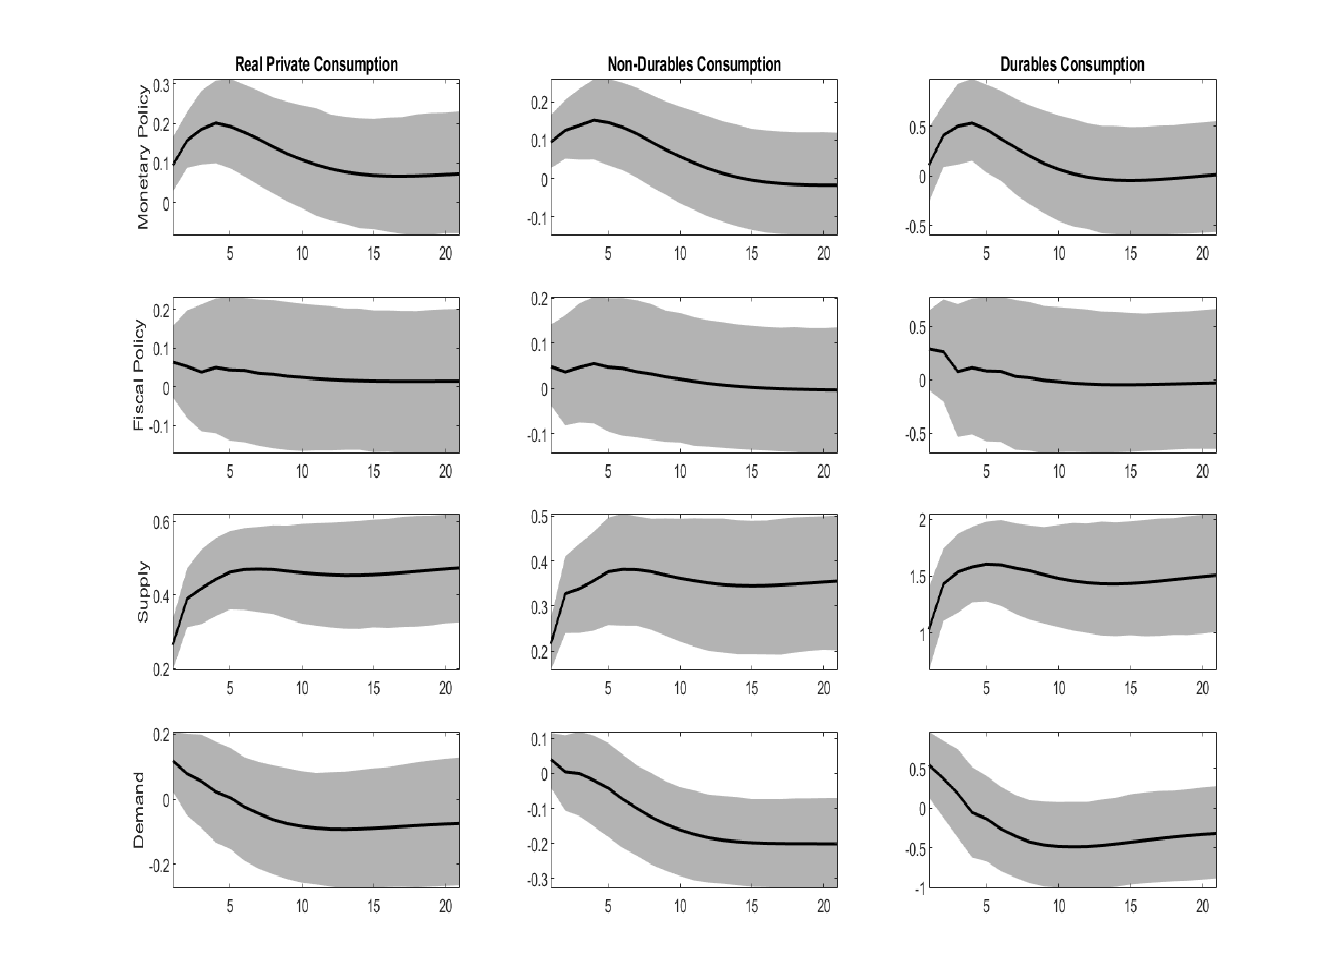
Figure 5. Impulse-response functions. Solid line point estimate, gray areas 68% confidence